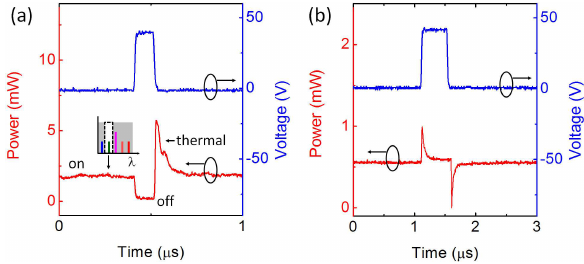
Figure 14: (a) The applied control voltage and the recorded comb line power variation. Inset illustrates the selected comb line after an optical band pass filter. A thermal effect is observed from off to on state. (b) The optical transmission of micro-ring resonator due to the applied modulation voltage in linear region for comparison. The thermal effect is also observed after the fast electro-optic switch-